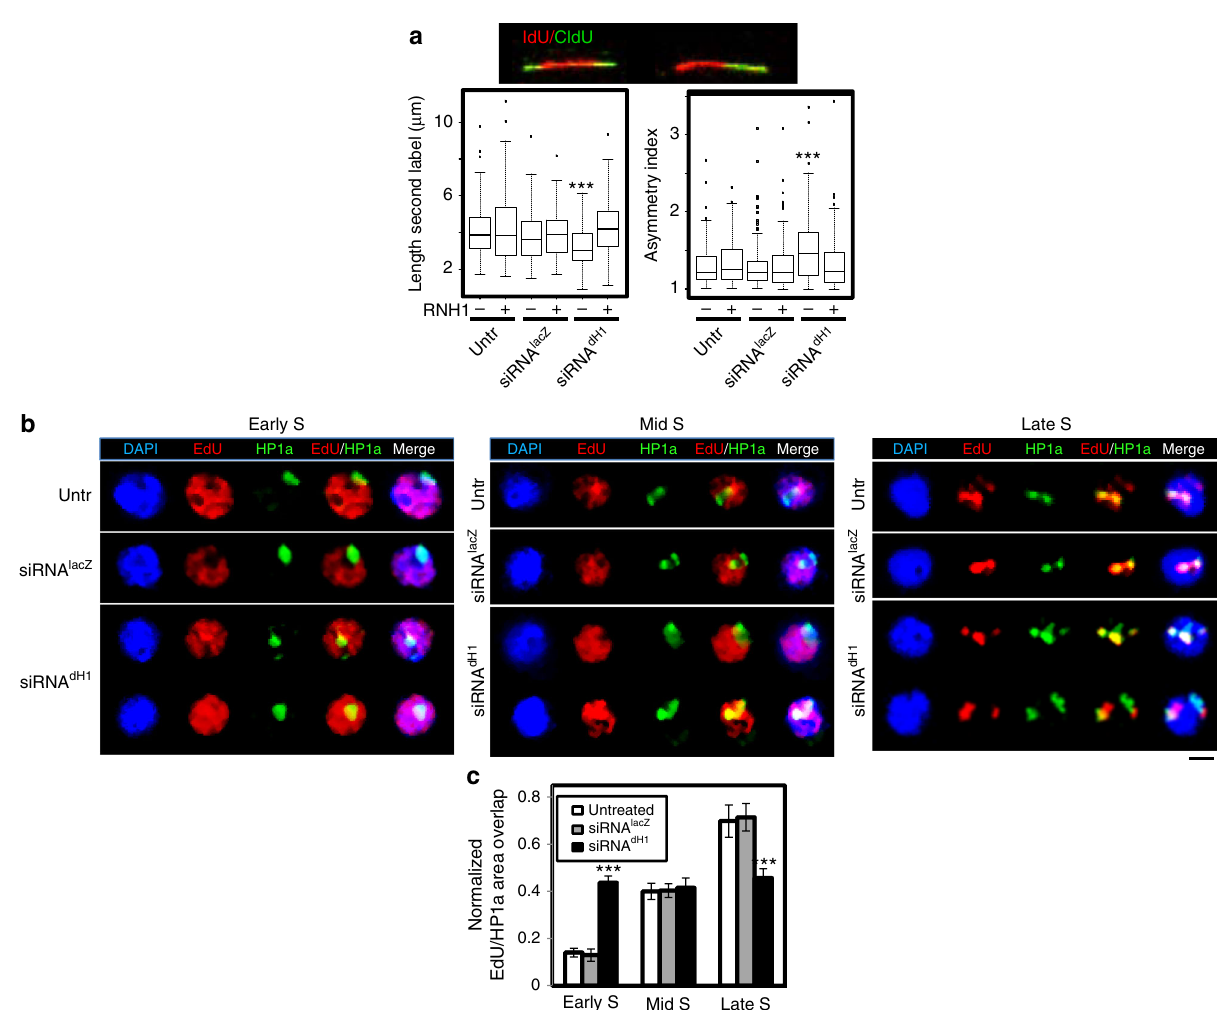
Fig. 6 dH1 depletion affects DNA replication. a On the top , DNA fi bers labeled with a double pulse of IdU (1 st label, red ) and CldU (2 nd label, green ). On the bottom , box-plots showing the length of the 2 nd label ( left ) and the asymmetry index ( right ) of DNA fi bers obtained from siRNA dH1 , siRNA lacZ and untreated cells overexpressing RNH1 ( + ) or not ( − ) ( n > 100 for each condition). Error bars are s.e.m. The p -values of siRNA dH1 respect to siRNA lacZ are indicated (no asterisk > 0.05, *** < 0.005; two-tailed Wilcoxon test). b Staining for EdU ( red ) and immunostaining with α HP1a ( green ) of siRNA dH1 , siRNA lacZ and untreated cells sorted at early, mid and late S-phase. DNA was stained with DAPI ( blue ). Scale bar corresponds to 4 μ m. c The extent of EdU/HP1a colocalization determined as the normalized proportion of total α HP1a area that shows EdU incorporation is presented ( n > 50 for each condition). Error bars are s.e.m. The p -values of siRNA dH1 respect to siRNA lacZ are indicated (no asterisk > 0.05, *** < 0.005; two-tailed Student ’ s t